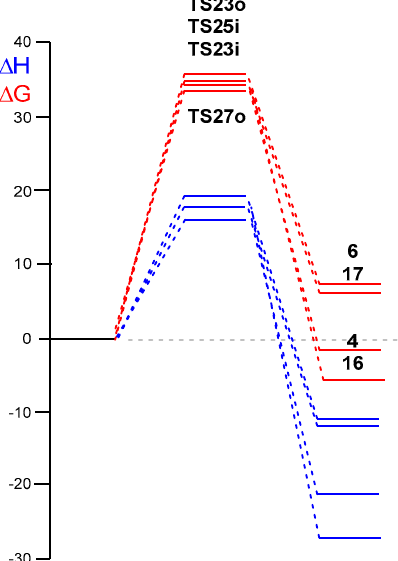
Figure 3. ω B97X-D/6-311G (d,p) enthalpy ( Δ H in kcal mol –1 ), in blue, and Gibbs-free energy ( Δ G in kcal mol –1 ), in red, profiles, in benzene at 80 °C, of the stationary points involved in four more favorable reaction paths associated with the cycloaddition reaction of tropone 1 with Cp 3 .